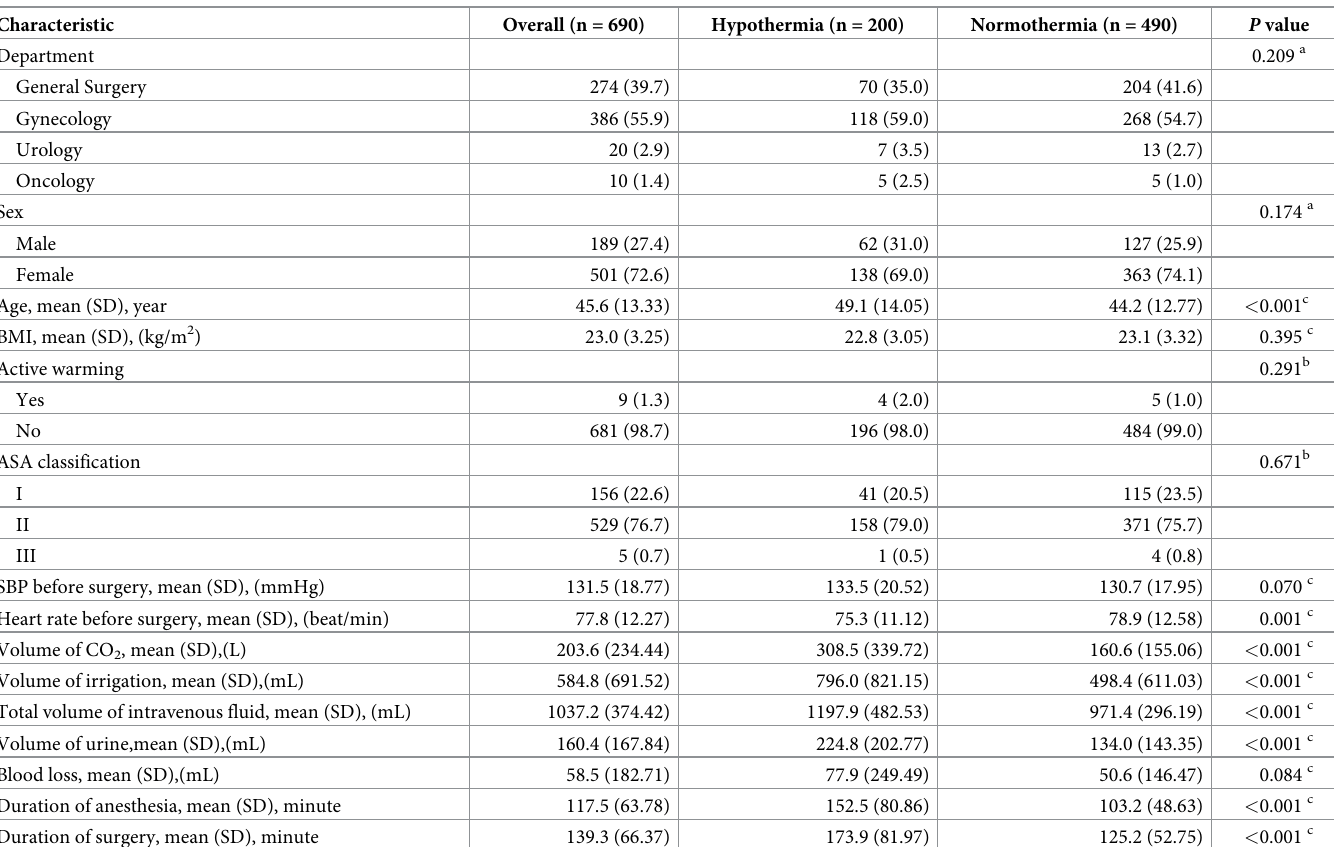
Table 1. Patient characteristics of the study.